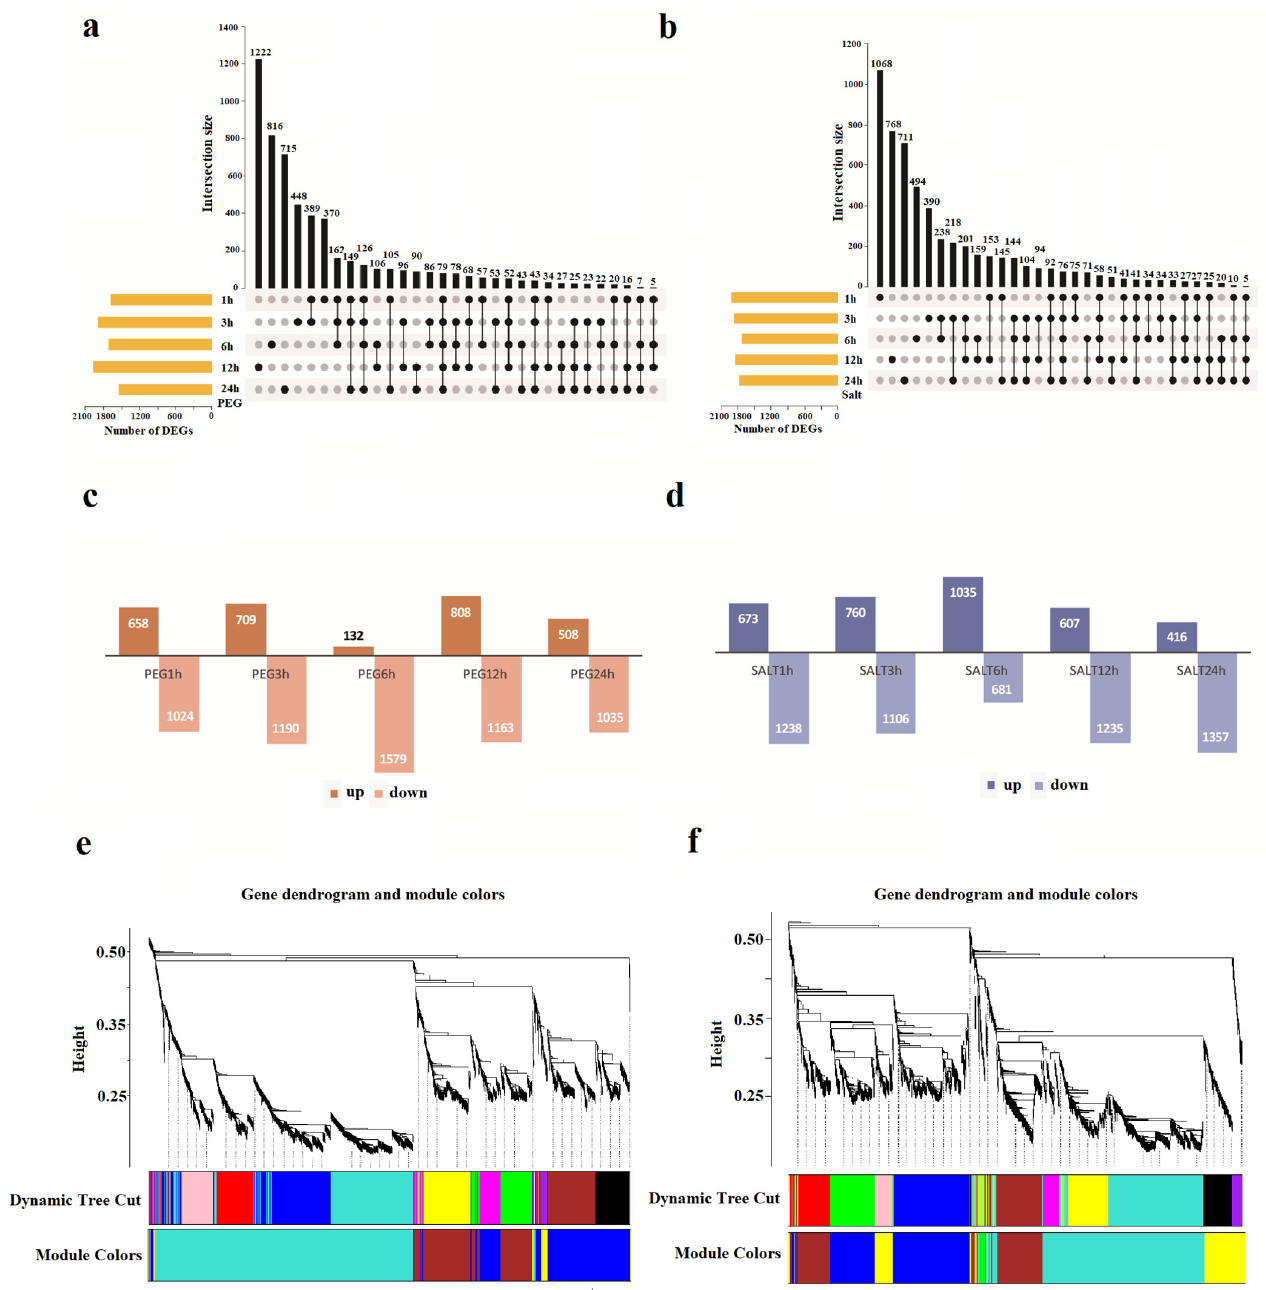
Figure 1. Expression dynamic changes, as well as comparative and module detection analysis of DEGs between the drought and salinity stresses. ( a ), Upset chart of the DEGs number in different time stages under PEG treatment. ( b ), Upset chart of the numbers of DEGs in different time stages under salinity treatment. ( c ), Numbers of DEGs up-regulated and down-regulated under PEG treatment. ( d ), numbers of DEGs up-regulated and down-regulated under salinity treatment. ( e ), Gene co-expression modules of the PEG treatment. The columns represent modules and different colors represent different modules. ( f ), Gene co-expression modules of the salinity treatment. The columns represent modules and different colors represent different modules.